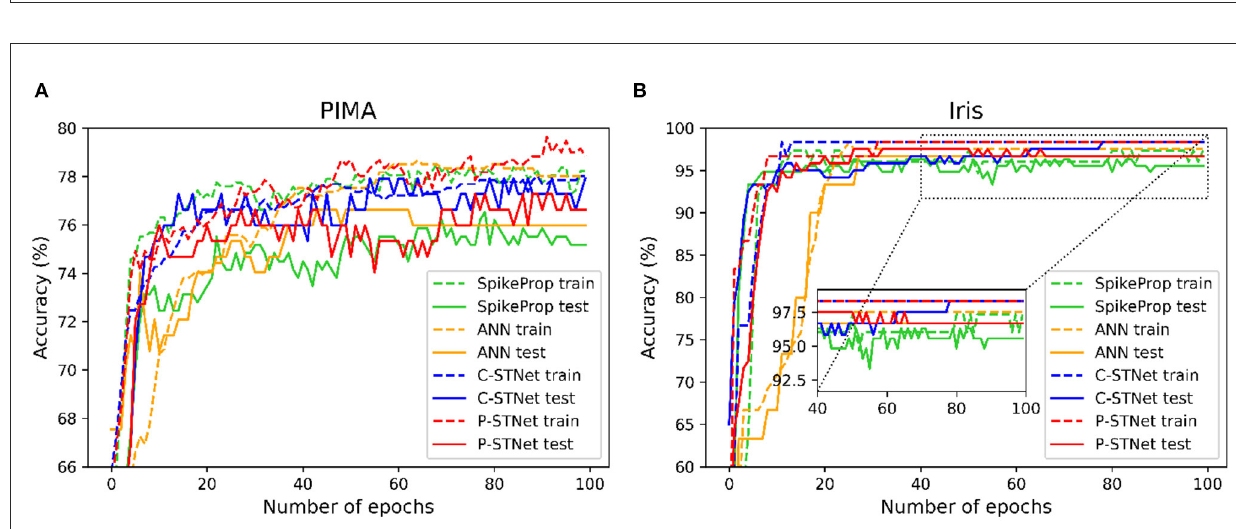
FIGURE8 Accuracy curves change as the number of epochs for four approaches on (A) : The two-classified PIMA dataset and (B) : The multi-classified Iris dataset.